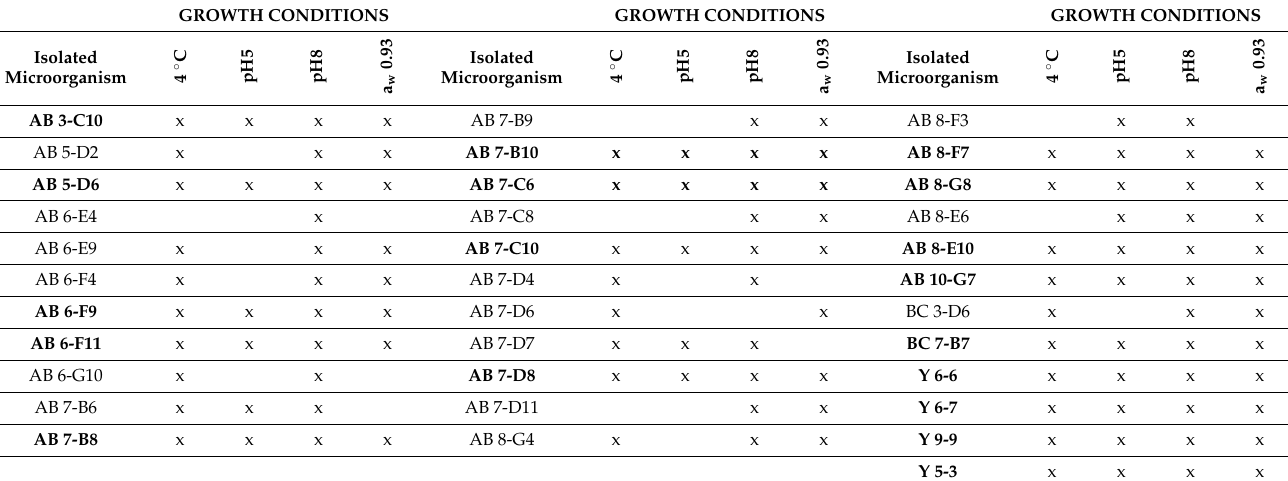
Table 1. Growth of soil bacteria isolated from actinomycete isolation agar (AB), bacteria isolated from TSA (BC) and yeasts isolated from PDA (Y) at different growth conditions: 4 ◦ C, pH 5, pH 8 and a w 0.93. Thecells with a cross indicate growth in each of the conditions. The bold isolate name indicates its selection in subsequent studies because it met all established criteria. All isolates and conditions were tested in